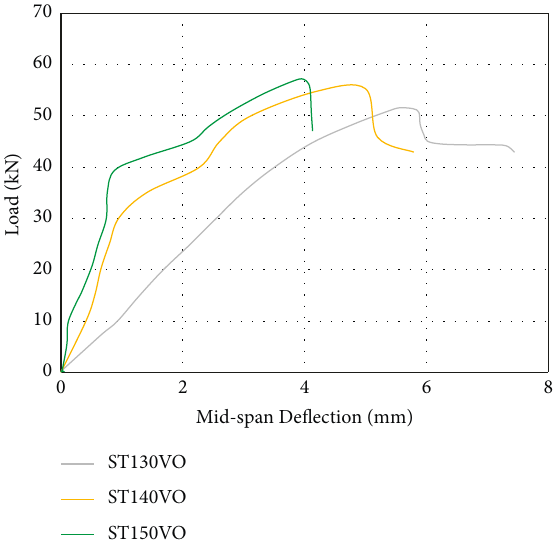
Figure 5: Load verse midspan deflection relations of all specimens.